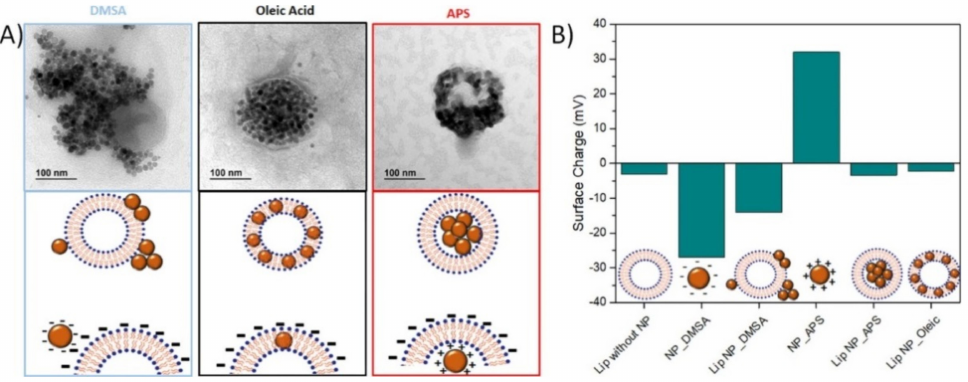
Figure 10. ( A ) TEM images and corresponding schemes of liposomes produced with iron oxide NPs using different coatings as dimercaptosuccinic acid (DMSA), oleic acid and (3-aminopropyl)trimethoxysilane (APS), resulting in different spatial configurations of the NPs. ( B ) Zeta potential measurements at pH 7 for these magnetoliposomes and the comparison with free NPs. Adapted with permission from Ref. [230], Copyright 2020 American Chemical